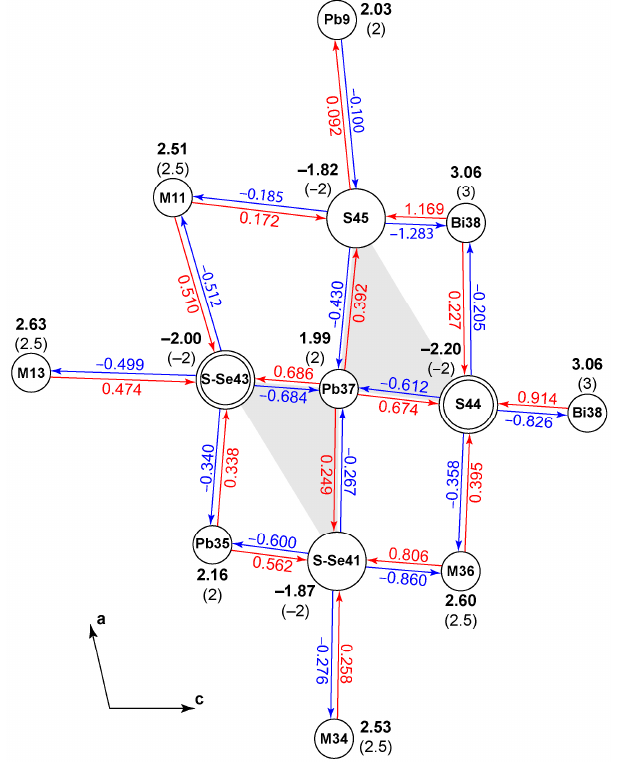
Figure 2. The charge distribution around Pb37 in the structure of cannizzarite (Topa et al. [21]). The formal charge of Pb37 ( q X = 2) is distributed to the ligands in proportion to the fractional weight of each bond (red arrows diverging from Pb37). The red figures are ∆ q Xij → A values calculated with Equation (5). The total charge Q A (e.g., − 2.204 for S44) received by each ligand, is the sum of ∆ q Xij → A from all the surrounding central atoms (red arrows converging to each ligand). The total charge 𝑄 (cid:3025) = 1.991 received back by Pb37 from its ligands (blue arrows converging to Pb37) is the sum of ∆𝑄 (cid:3036)(cid:3037) values calculated with Equation (7) (blue figures). Ideally, 𝑄 (cid:3025) and 𝑄 (cid:3002) should match the formal ox- idation numbers 𝑞 (cid:3025) and 𝑞 (cid:3002) , respectively (e.g. , +2 for Pb37 and − 2 for S44, S45, S–Se41, S–Se43). Fig- ures in bold lettering are the computed charges— 𝑄 (cid:3025) and 𝑄 (cid:3002) —with the formal oxidation numbers— 𝑞 (cid:3025) and 𝑞 (cid:3002) —in parentheses. M11, M13, M34, M36 symbols stand for mixed 0.5Pb–0.5Bi positions (𝑞 (cid:3051) = 2.5) . Double outlined circles represent pairs of crystallographically similar sulfur atoms over- lapping along the b axis. The shaded areas are projections of the two HSPs defined for the Pb37 CP. The overall deviations of 𝑄 (cid:3025) and 𝑄 (cid:3002) from 𝑞 (cid:3025) and 𝑞 (cid:3002) are checked through the cal- culation of the mean absolute percentage deviation ( 𝑀𝐴𝑃𝐷 ) (Eon and Nespolo [13]). As an